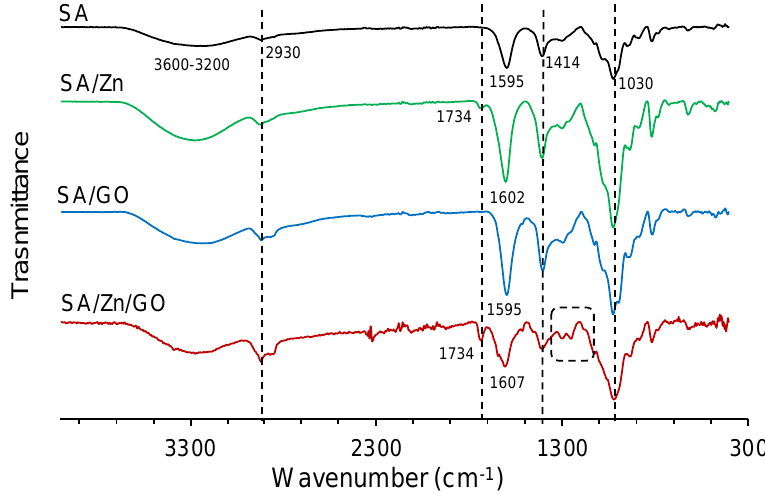
Figure 2. FTIR spectra of neat SA, SA / Zn, SA / GO, and SA / Zn / GO in the region of 4000–300 cm − 1 .